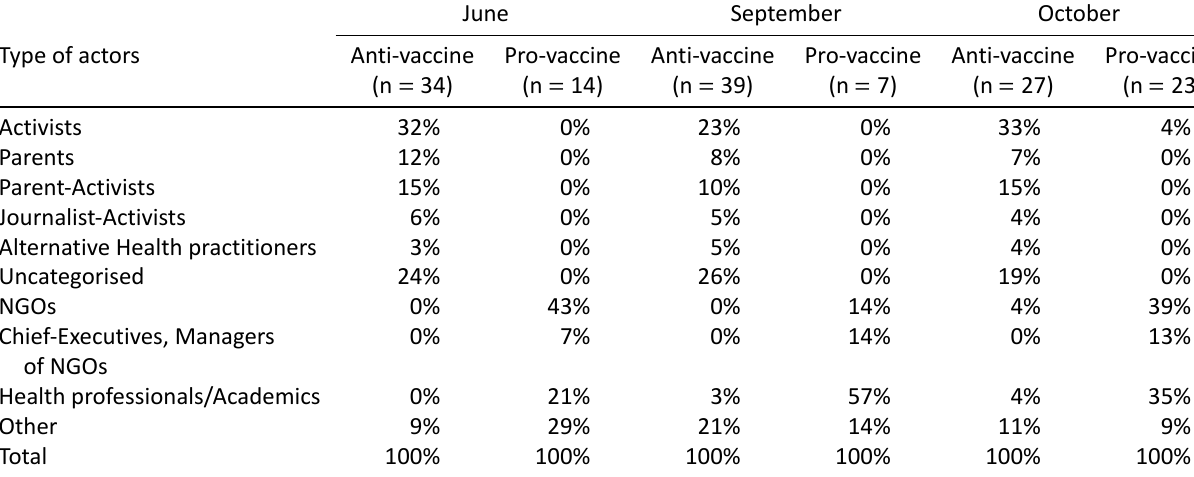
Table 2. Anti- and pro-vaccine key actors classified by type of